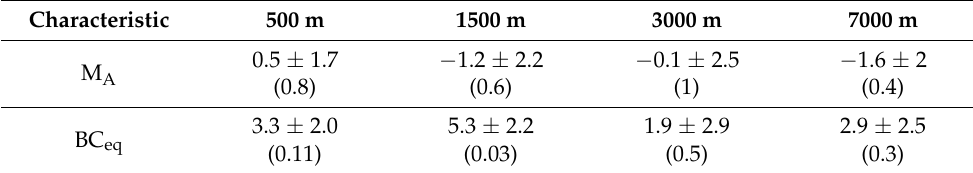
Table 4. Trend (% per year) concentrations of M A , BC eq , and their errors and significance ( p -value) at different altitudes in 2000–2018.